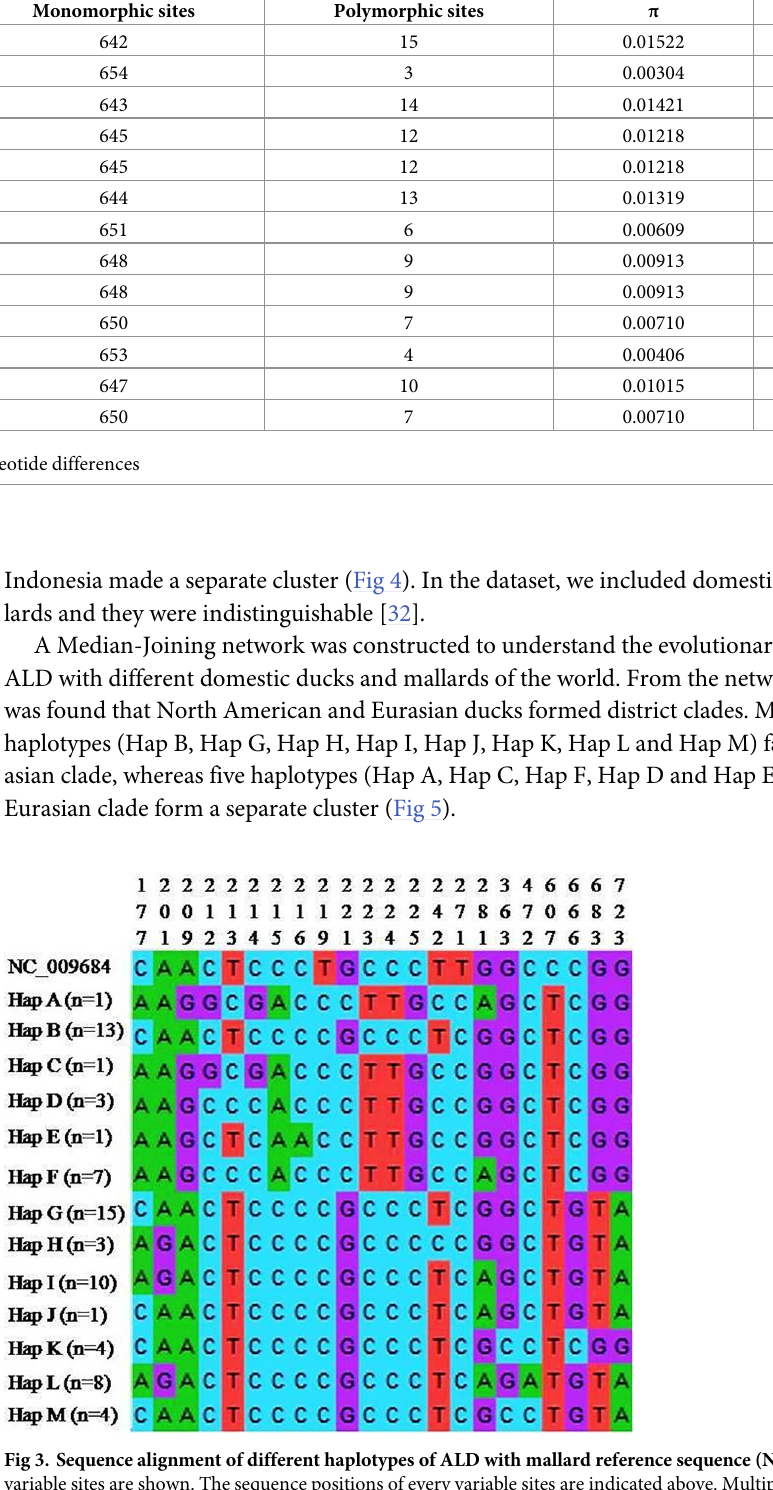
Table 1. Sequence polymorphism of different haplotypes of Andaman local duck (ALD) with reference sequence (NC_009684). Ref sequence compared with